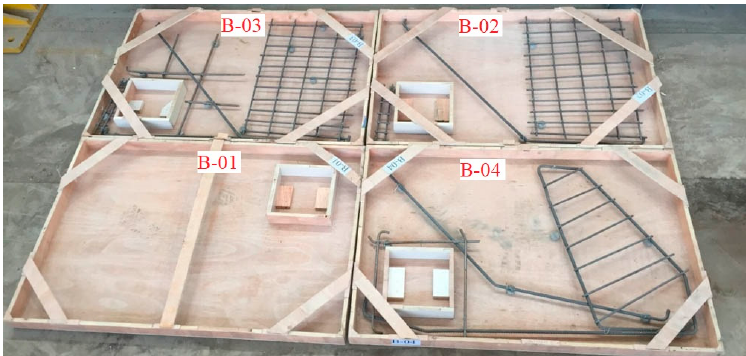
Figure 12. Framework and reinforcement cage of the Group A irregular concrete deep beam specimens.